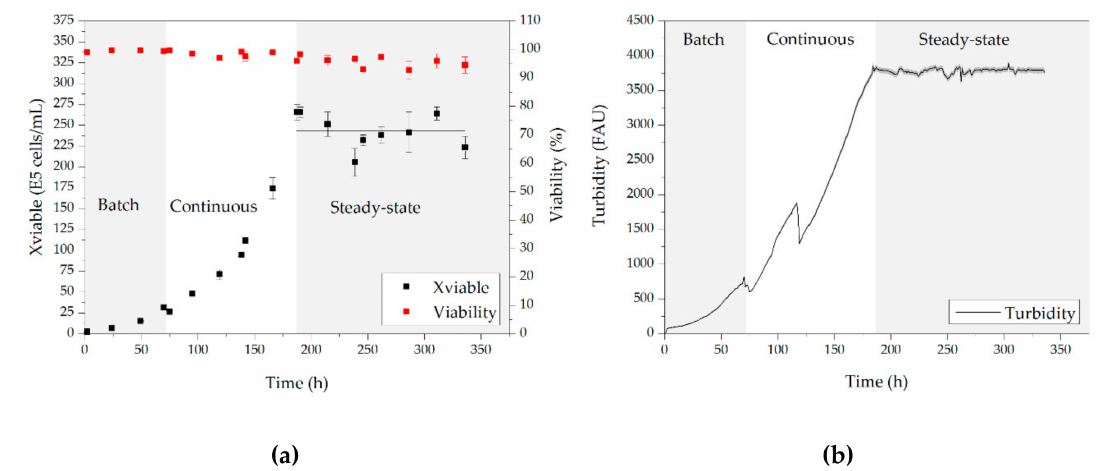
Figure 6. Viable cell concentration, cell viability ( a ) and turbidity ( b ) during continuous cultivation of CHO DG44. The horizontal line during steady-state cultivation depicts the mean viable cell concentration of 243.03 ± 19.63 × 10 5 cells / mL. Measurement uncertainty of turbidity ( ± 3%) is indicated as a grey enveloping curve. Error bars depict the double determination of cell concentration and viability.